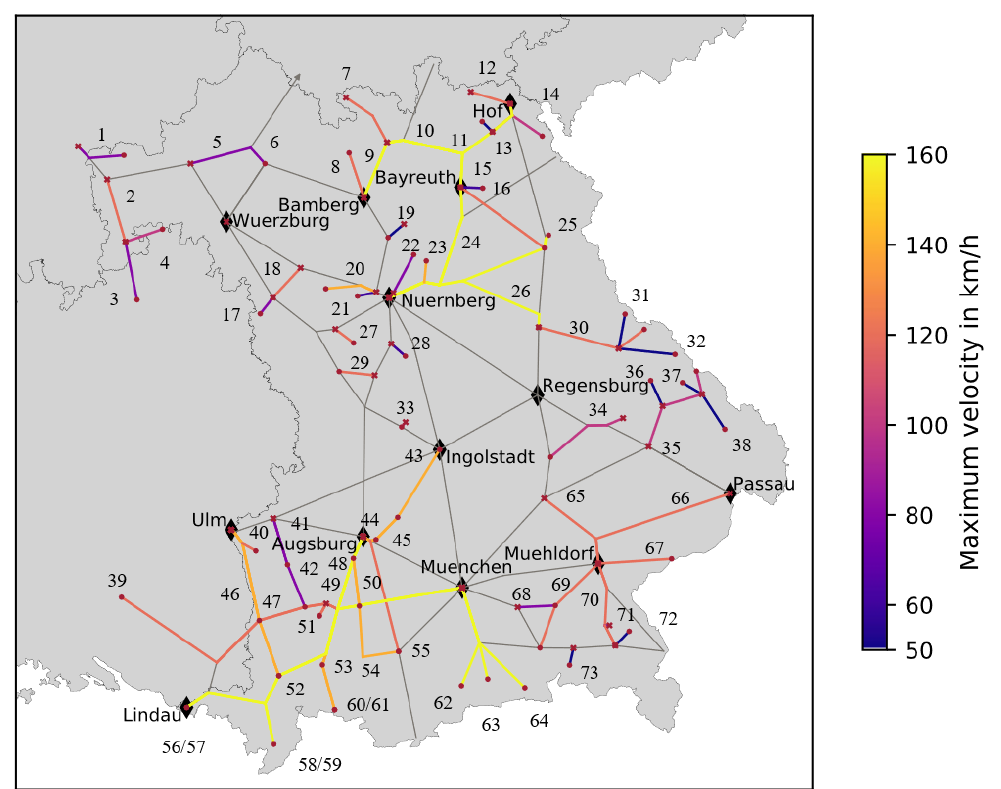
Figure 7. Figure B2: Maximum velocity on current diesel